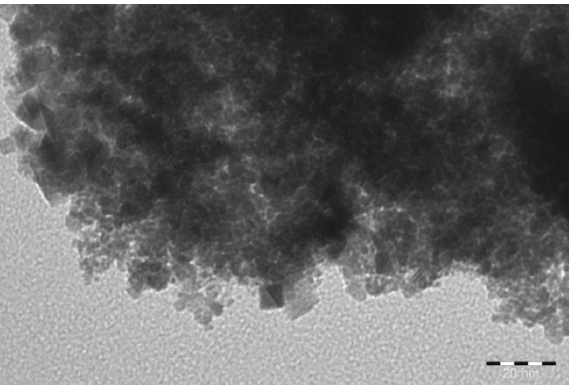
Fig. 3 – TEM micrograph of the prepared catalyst